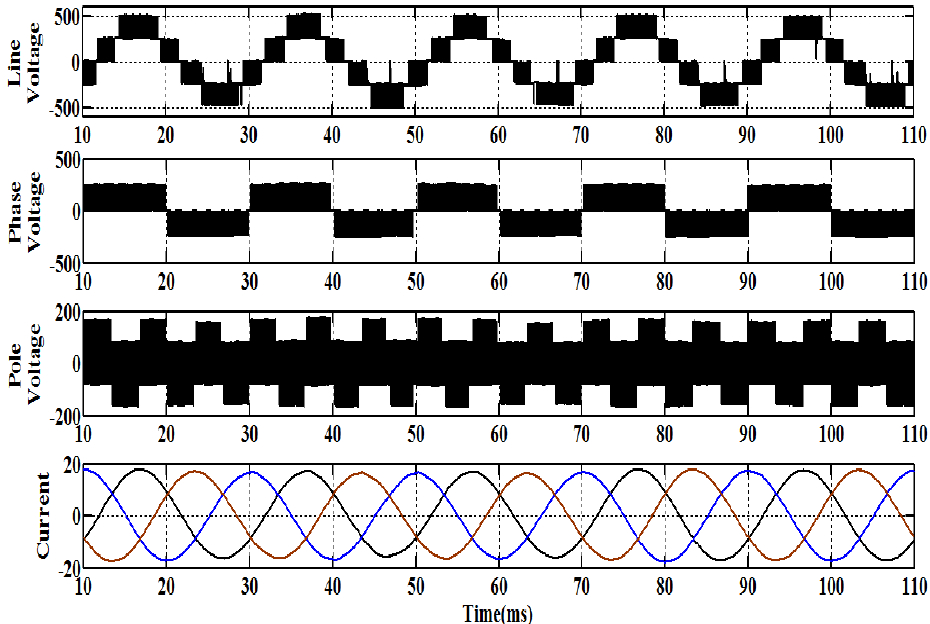
Figure 13. Output of the ZSI with two impedance networks, using phase disposition (PD) PWM with M = 1.15*0.7, To / T = 0.3, fc = 5.5 kHz).